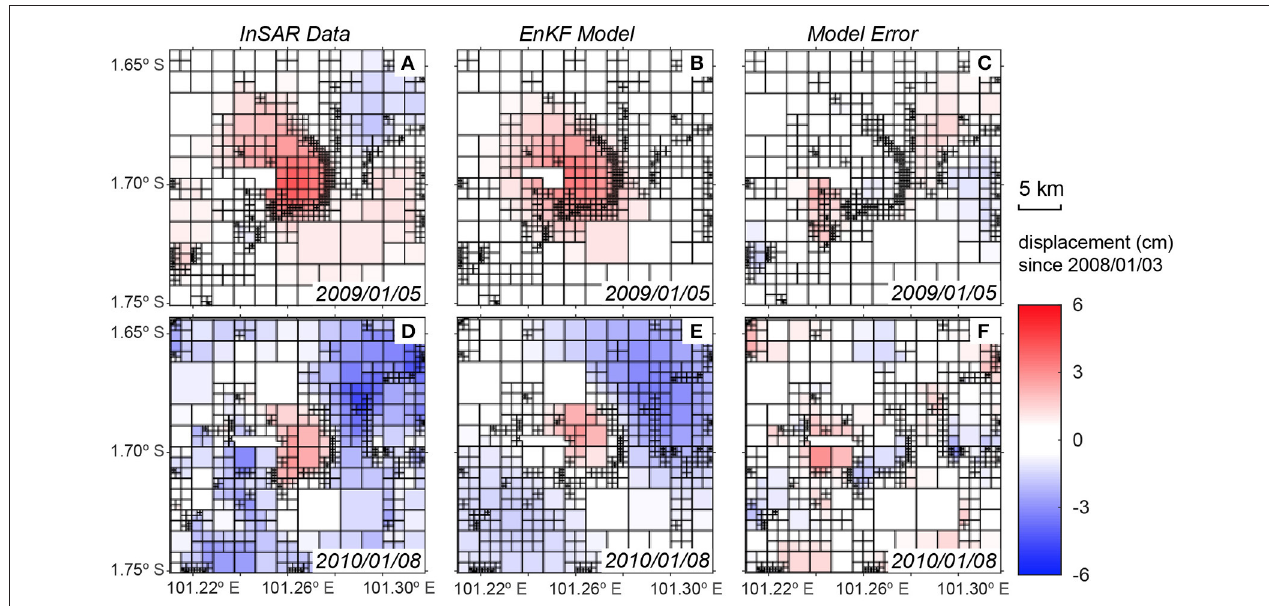
FIGURE 3 | Comparison between the QuadTree down-sampled InSAR time series (A,D) and the EnKF data assimilation results (B,E) , before (top row) and after (bottom row) the 2009 eruption. (B,E) show the best fit two-sources model obtained from the EnKF data assimilation and (C,F) show the misfit between the EnKF prediction and the InSAR